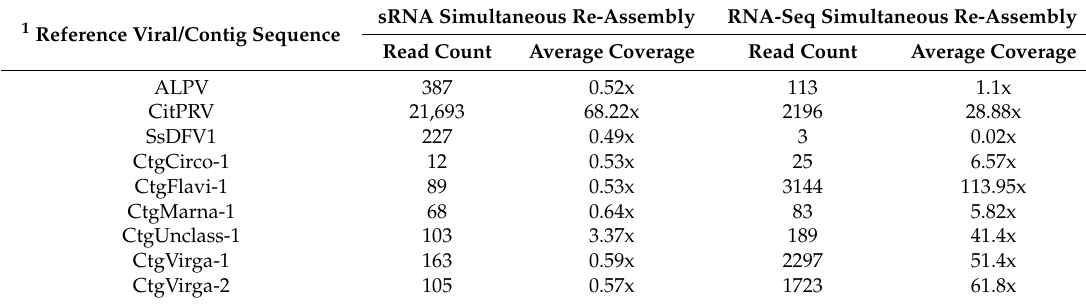
Figure 3. Profile distribution of total reads from the RNA ‐ seq ( a ) and sRNA ( c ) libraries; and reads from combined asymptomatic ( b ) and symptomatic ( d ) libraries along the Citrus endogenous pararetrovirus (CitPRV) genome. Genome organization of the CitPRV reference is shown above the graphics. Color scale varies from 0 (light blue color) to 100% (red color) of coverage. Table 5. Comparison of re ‐ assembly data among different viral sequences identified in this study. Read count and average coverage from the simultaneous re ‐ assembly analysis are shown for each viral sequence.